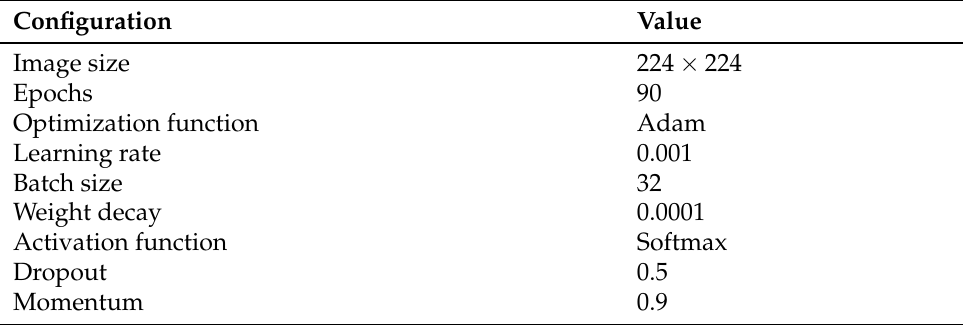
Table 2. Configuration of model